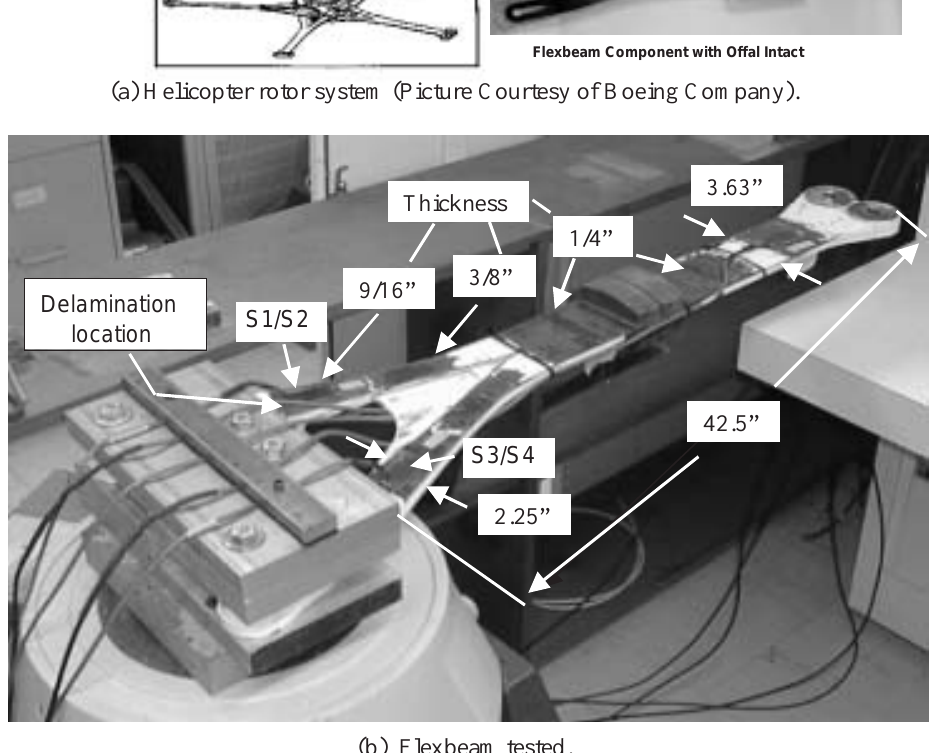
Fig. 15. Schematic of a helicopter rotor system and a helicopter